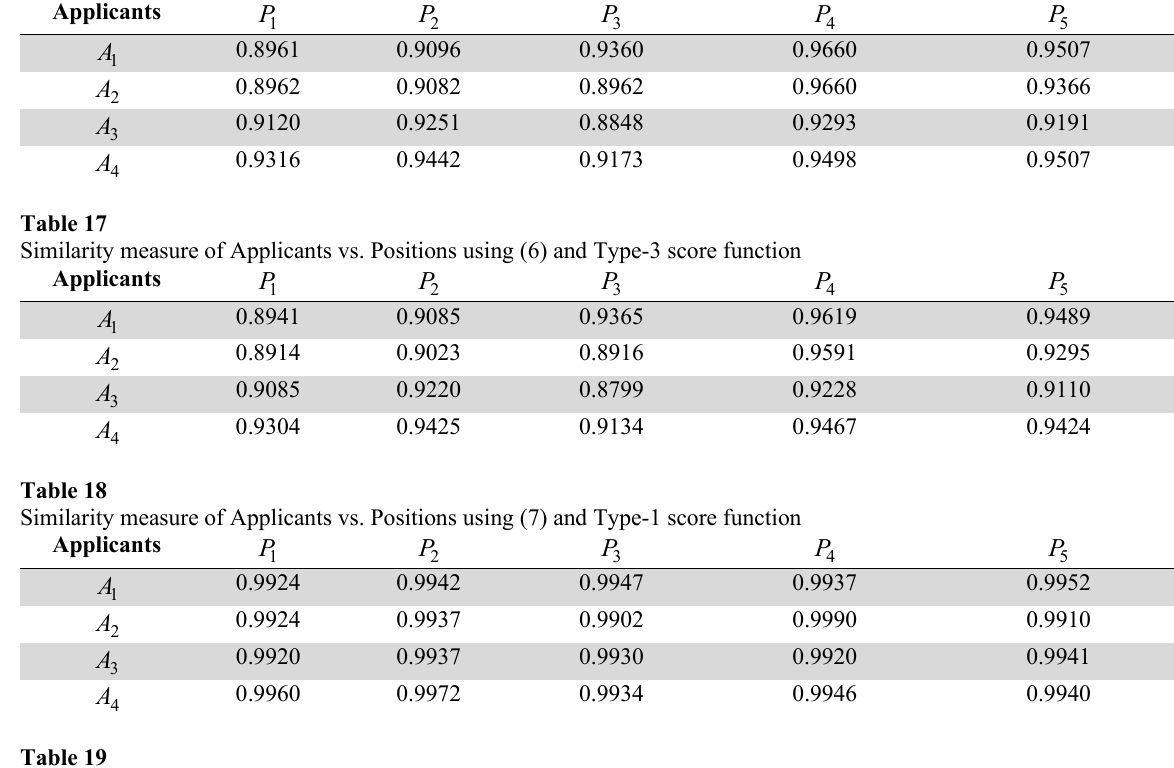
Similarity measure of Applicants vs. Positions using (6) and Type-2 score function